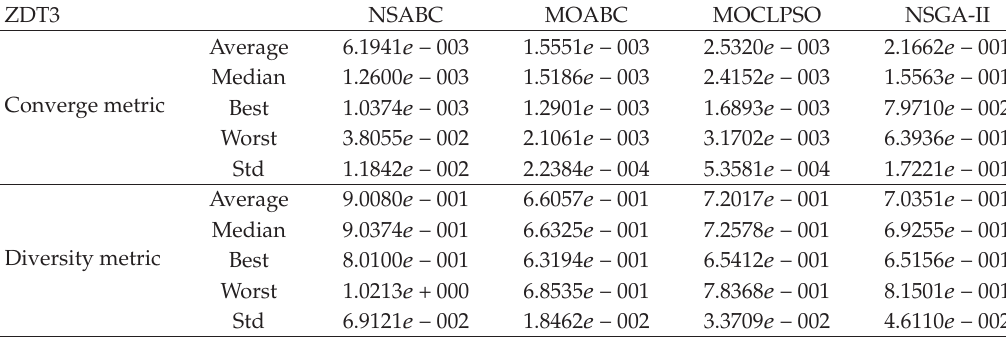
Table 9: Comparison of performance on ZDT3 after 10000